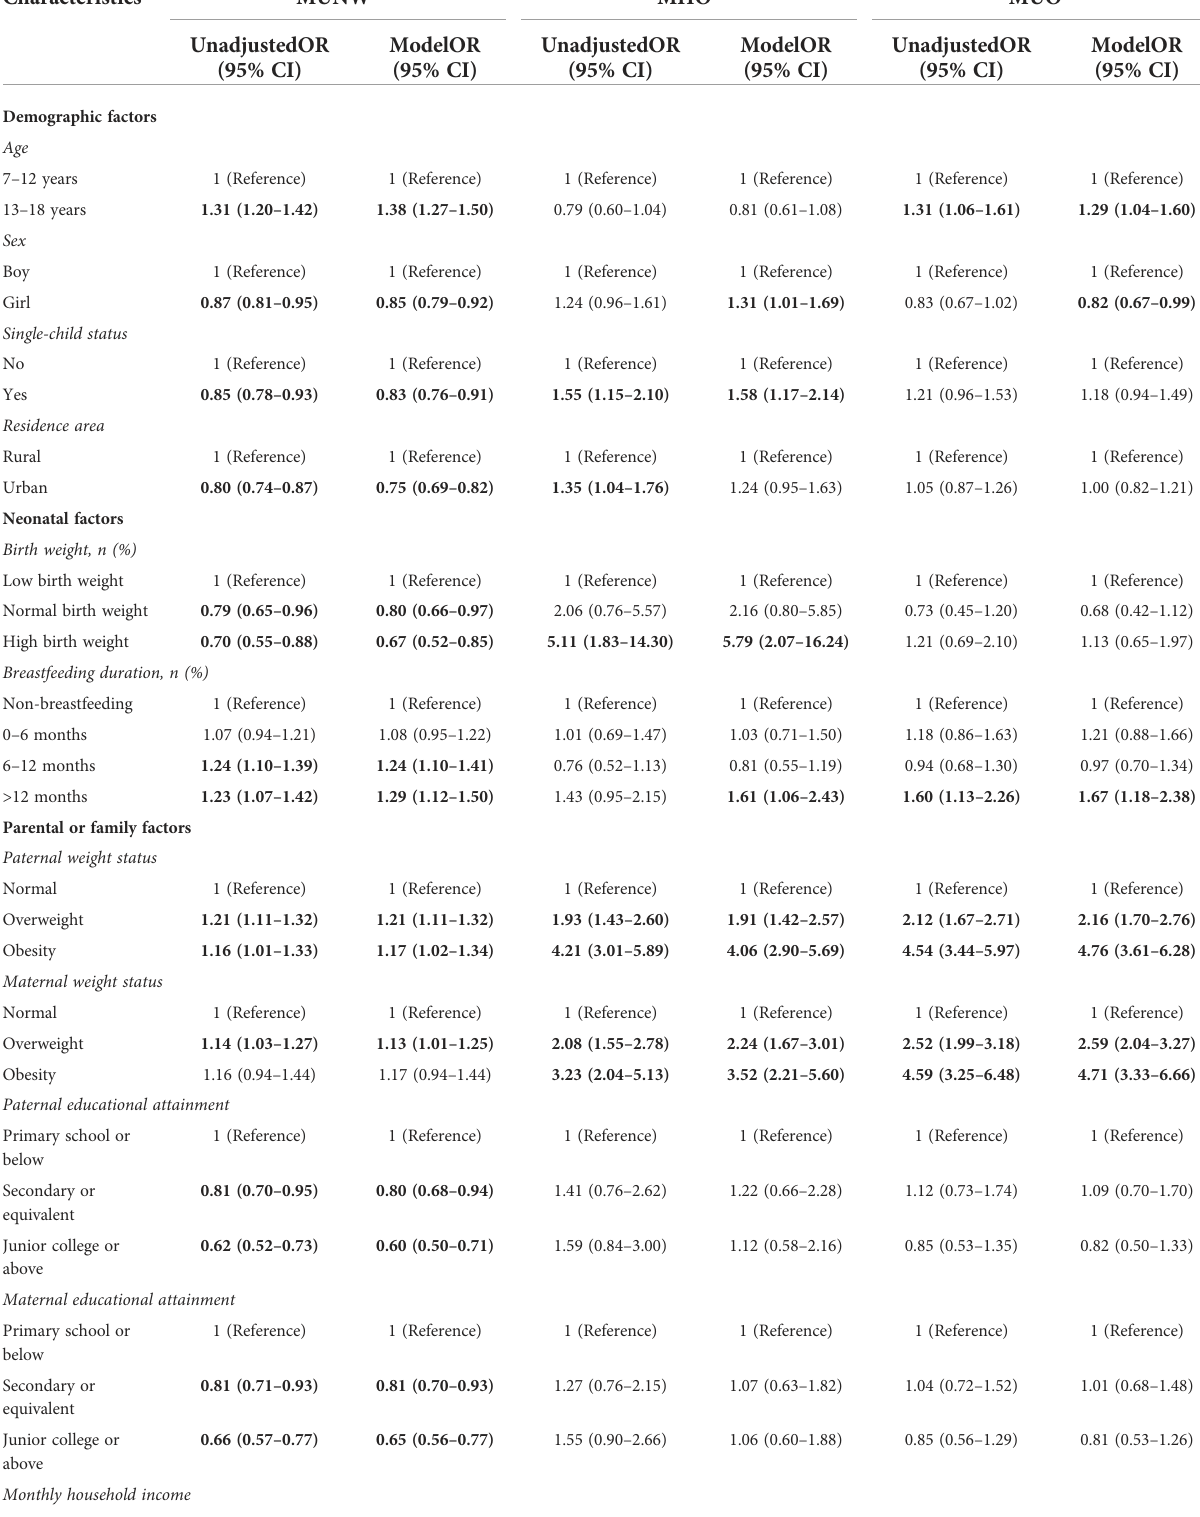
TABLE 4 Odds ratios for different metabolic obesity phenotypes associated with demographic, neonatal, parental, or family factors, based on 2018 consensus-based